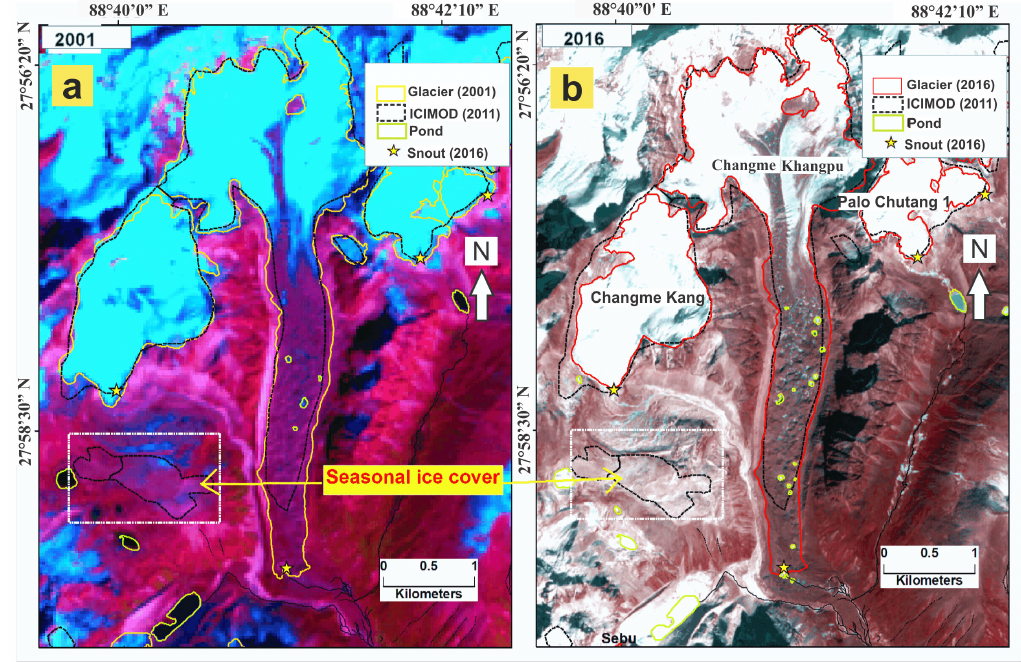
Figure 5. Differences between glacier outlines delineated by ICIMOD (2011) and the present study of